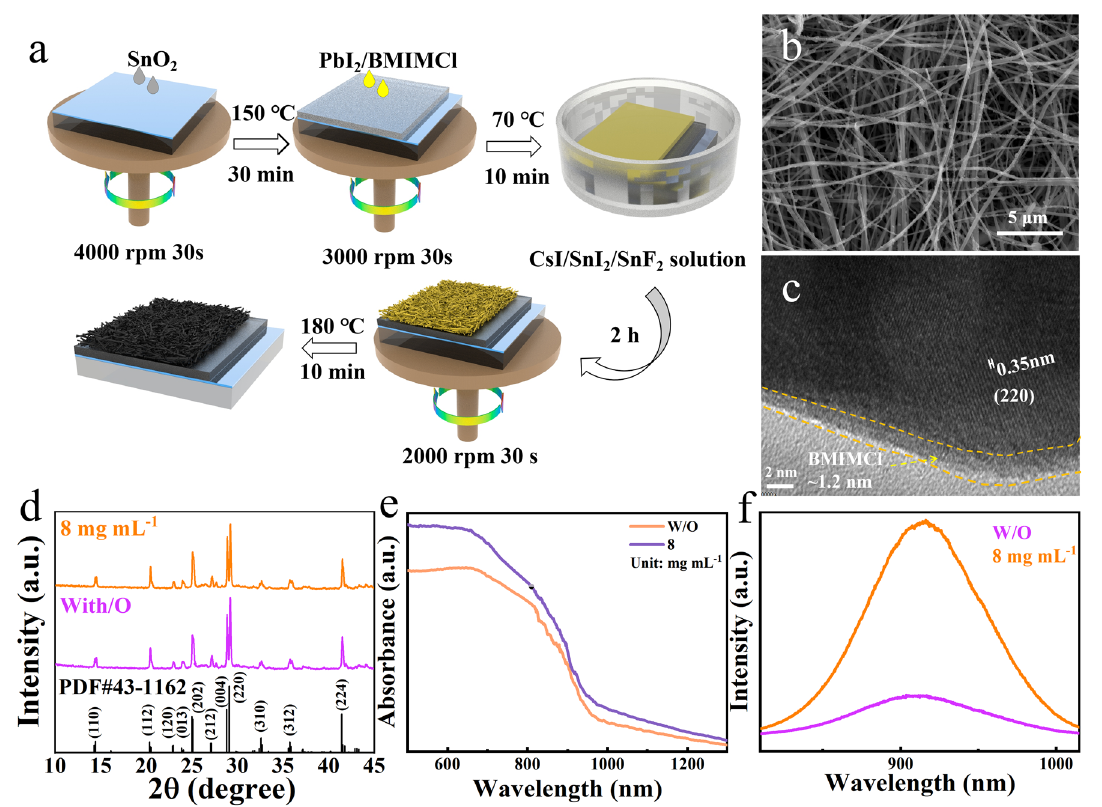
Fig. 1 a Flow chart for the preparation of CsSnI 3 NWs. b Surface SEM and c HRTEM of CsSnI 3 NWs with BMIMCl. d XRD, e optical absorp- tion and f steady-state PL curves of CsSnI 3 NWs with or without 8 mg mL −1